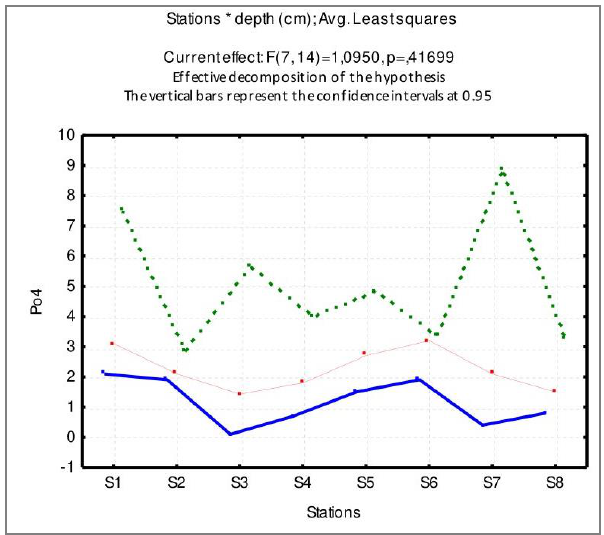
Figure 3. Spatial variation in the concentrations of PO Reghaia Lake.